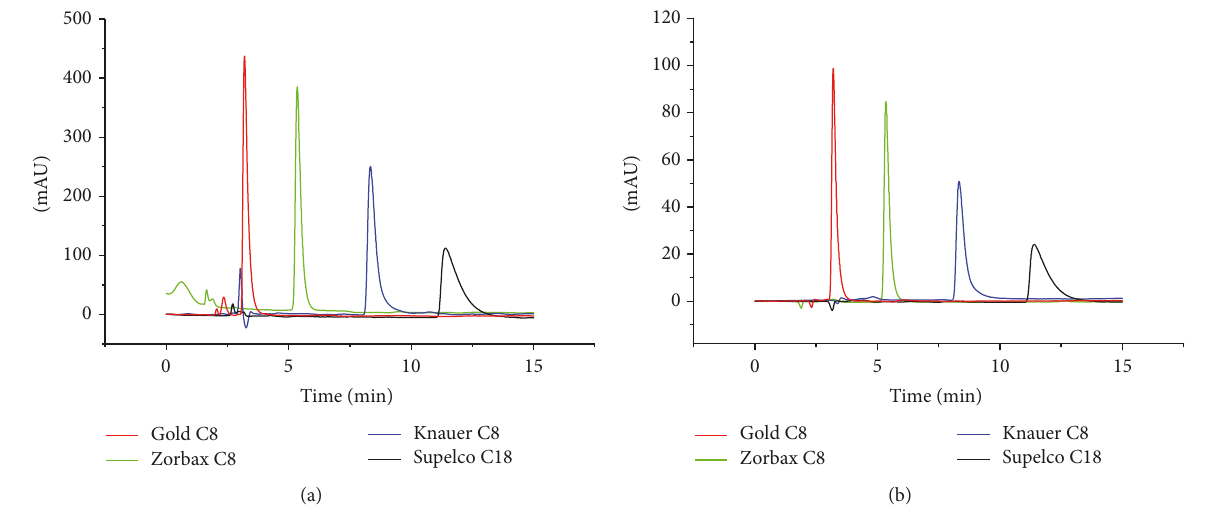
Figure 1: Optimisation of columns for (a) 207 nm and (b) 286 nm.